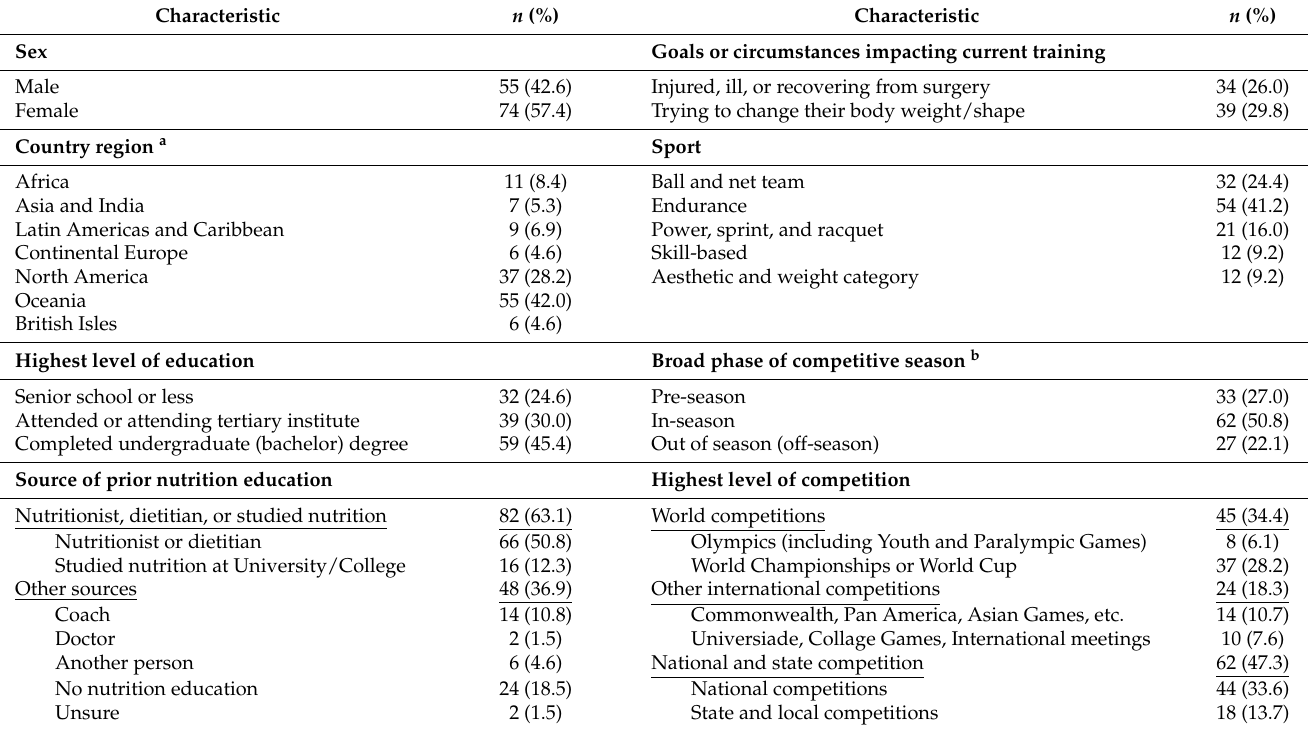
Table 2. Participant characteristics of 131